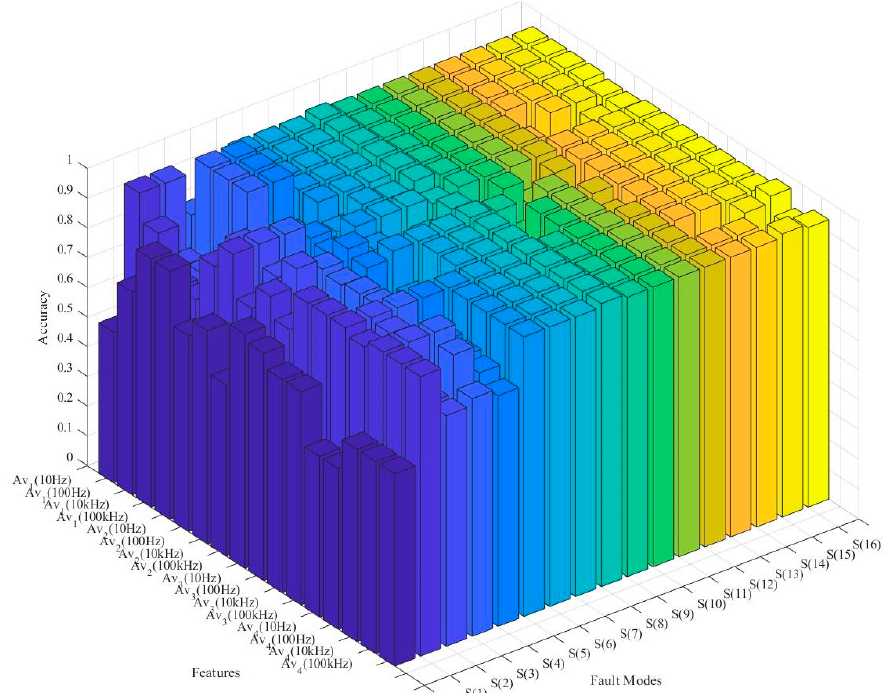
Figure 7. Analog circuit diagnostic tree potential ELM model accuracy comparison.